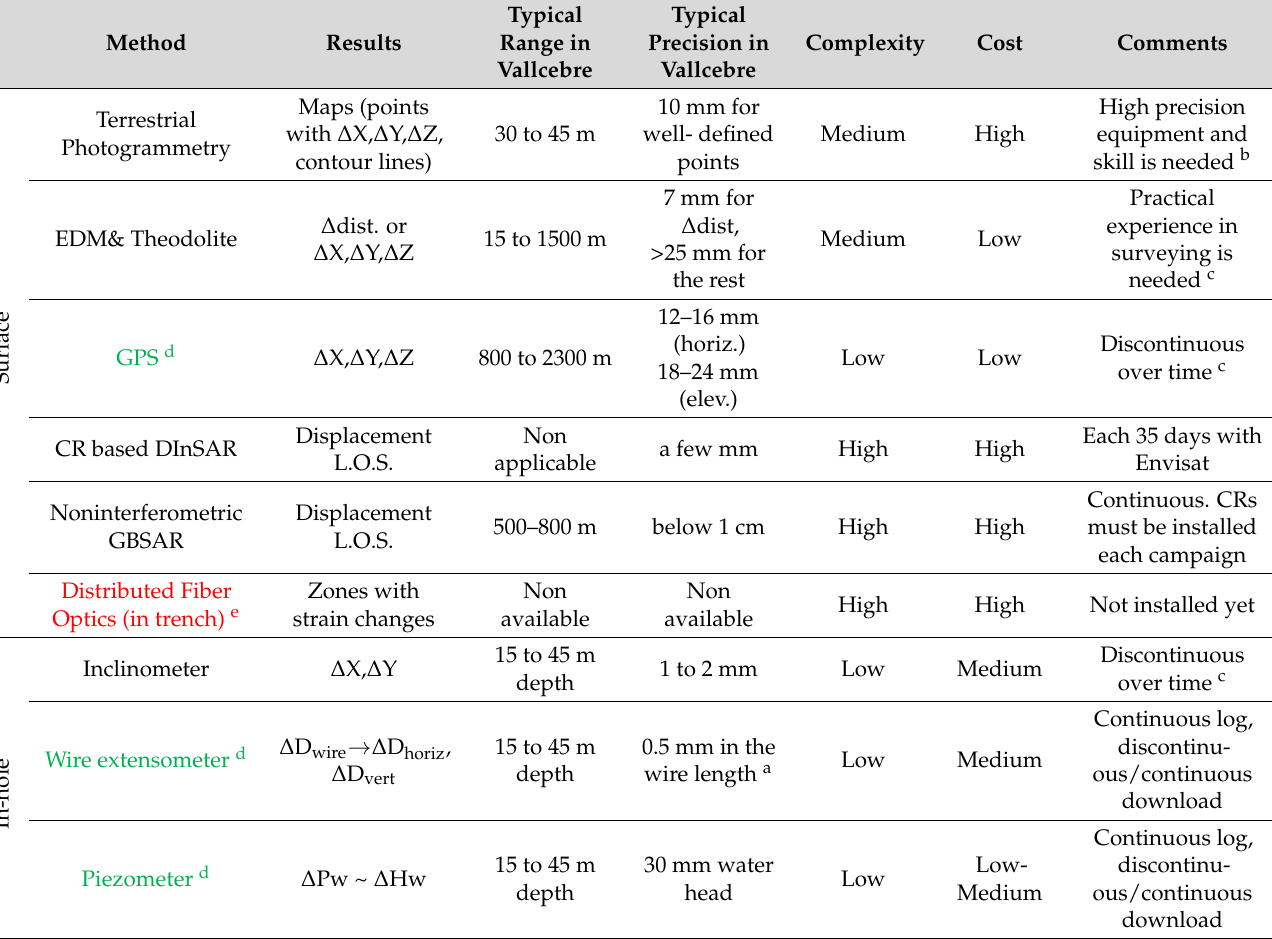
Table 1. Overview of the methods used in Vallcebre landslide